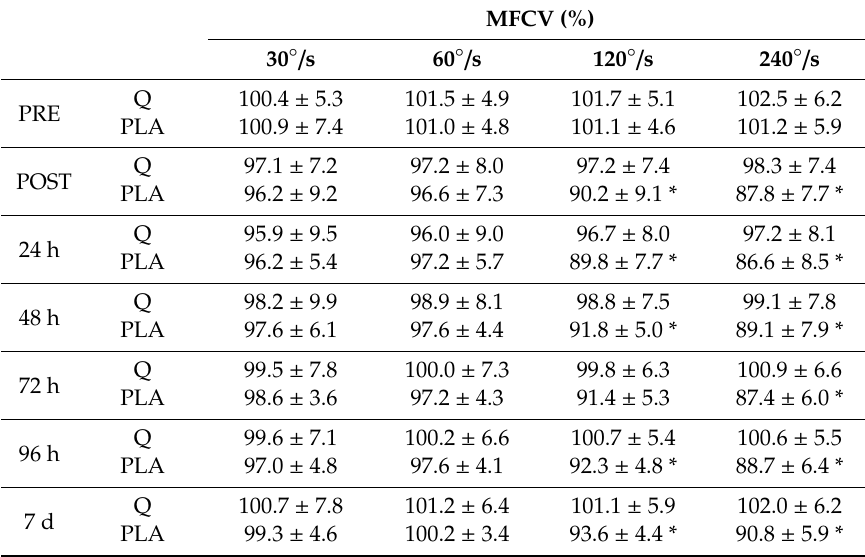
Table 1. MFCV in Q and PLA conditions before, after the EEIMD and during the recovery at the di ff erent angular velocities of the FV